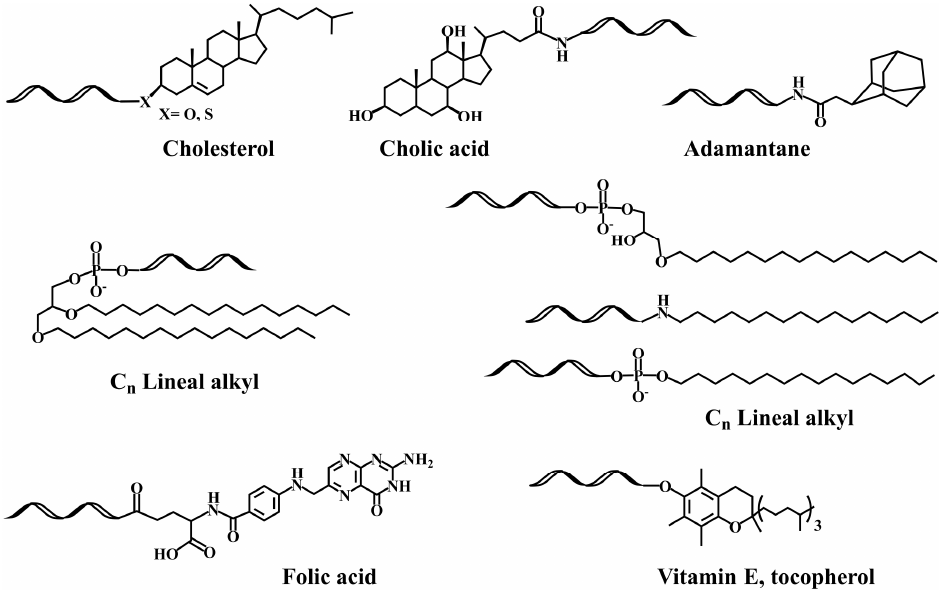
Scheme 1. Structure of several lipid-oligonucleotide conjugates